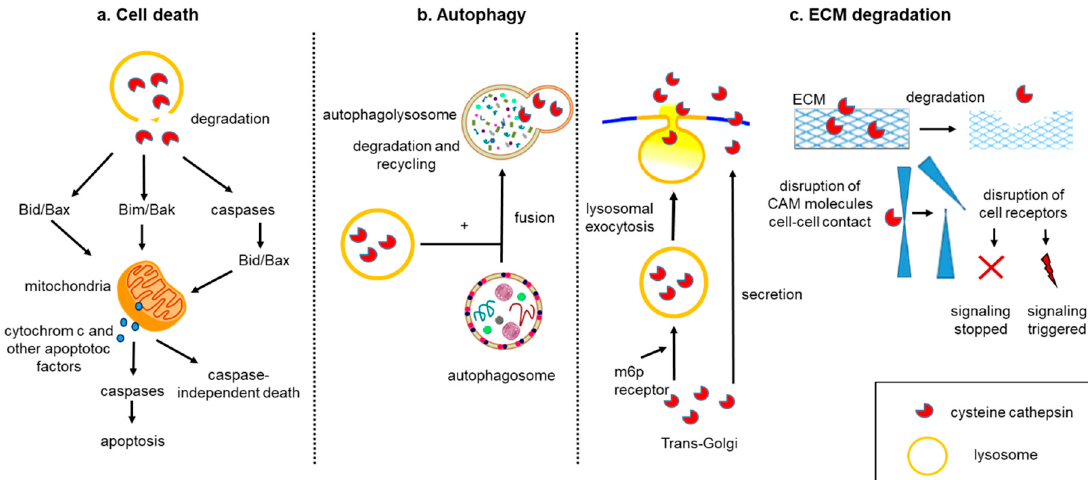
Figure 2. Role of Cts in cell death, autophagy, and ECM degradation. ( a ) Cts are released into the cytosol and are involved in apoptotic pathways. The first pathway includes a direct cleavage of Bid and / or Bak / Bim, translocation of these pro-apoptotic proteins to the mitochondrial outer membrane, which induces the release of apoptogenic factors such as cytochrome c and subsequent activation of downstream caspases and apoptosis. The second pathway involves a direct cleavage of caspases followed by cleavage of Bid and / or Bax, translocation of these proteins to mitochondria, and similar downstream events leading to apoptosis. The third option is independent-caspase apoptosis. ( b ) Upon induction of autophagy, cytoplasmic materials are sequestered by a double-membraned structure, autophagosome, which fuses with lysosomes to become autolysosomes. In autolysosome, the